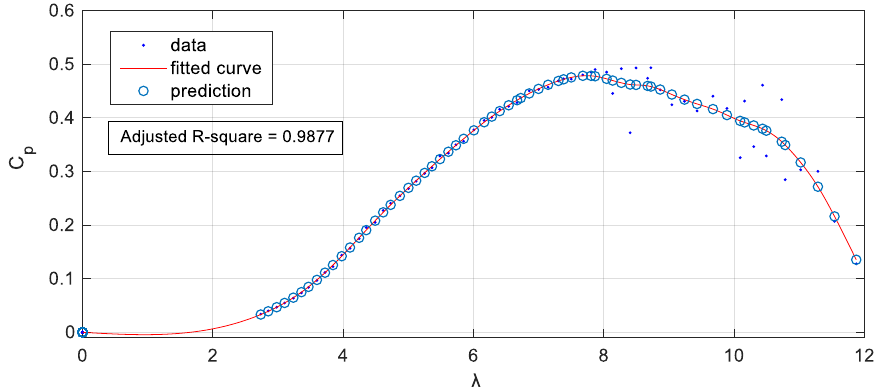
Figure 7. Resulting interpolation from the obtained control points with cubic spline interpolation method.